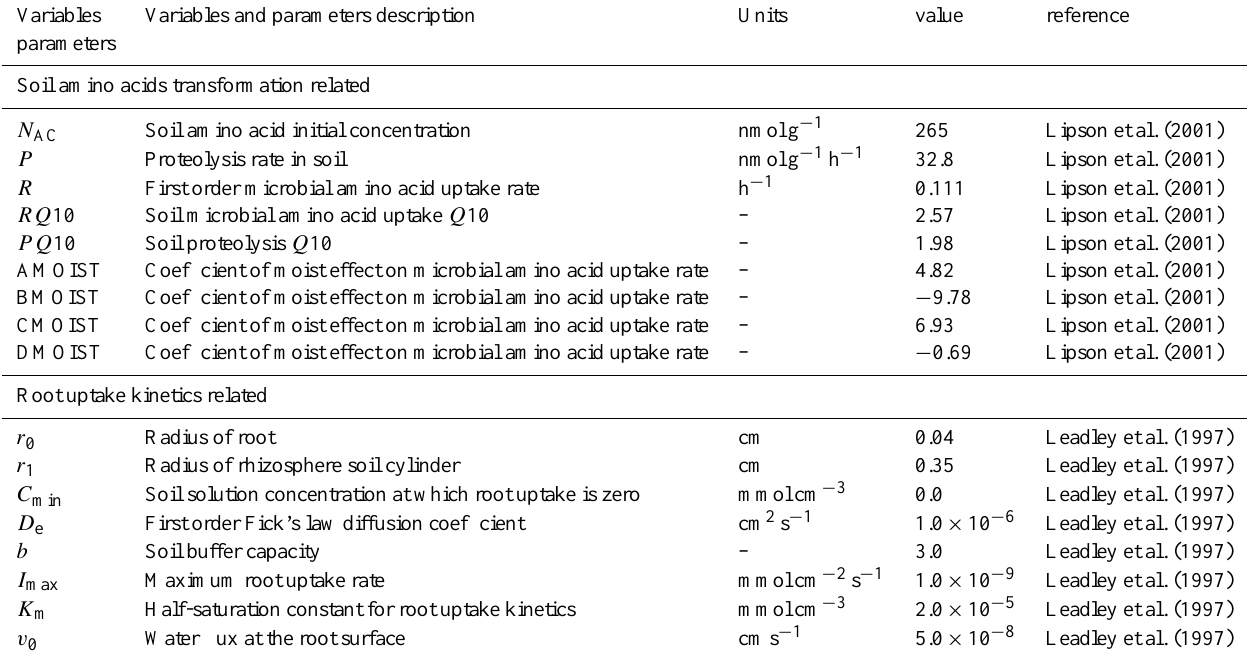
Table 3. New parameters introduced in ON-TEM.